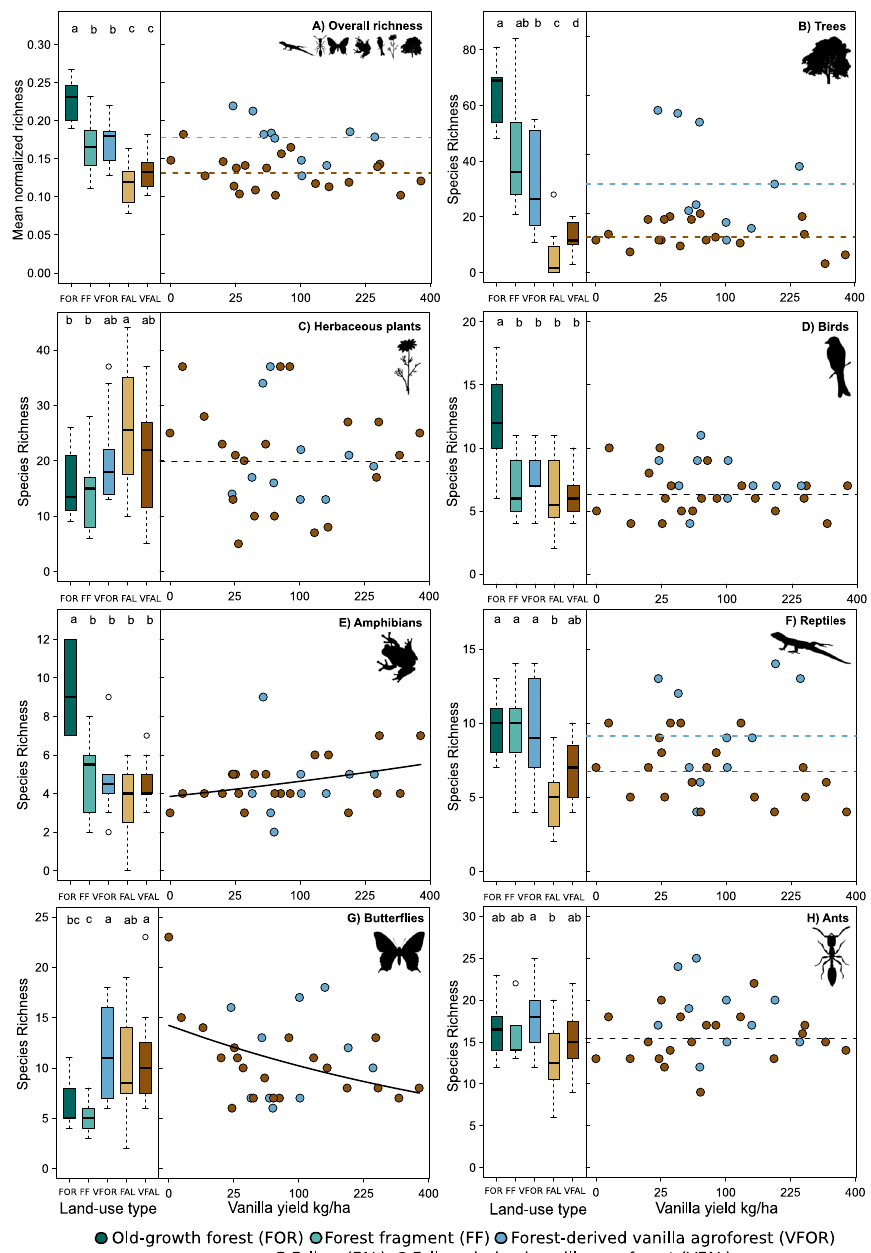
Fig. 1 Overall species richness (mean normalized richness across all taxa) and individual species richness of seven taxonomic groups across land-use types and with increasing vanilla yield. Shown are boxplots of plot-level mean normalized richness across taxa ( A ) and species richness of seven taxa individually ( B – H ) in old-growth forest (FOR = dark green), forest fragment (FF = light green), forest-derived vanilla agroforest (VFOR = blue), fallow (FAL = yellow) and fallow-derived vanilla agroforest (VFAL = brown). n = 10 for each FOR, FF and VFOR & n = 20 for each FAL and VFAL. The line inside the boxplot represents the median of each land-use type. The lower and upper boundaries of the boxplot show the 25th – 75th percentiles of the observational data, respectively, and the whiskers show the 1.5 interquartile range. Outliers are shown as dots. Letters indicate signi fi cant differences between land-use types based on pairwise Tukey ’ s honest or Wilcoxon signi fi cance tests (Statistical test results in Supplementary Tables 4 – 6). Scatterplots (VFOR = blue and VFAL = brown) show the relationship between plot-level mean normalized richness ( A ) and plot-level species richness of the seven taxa ( B – H ) with vanilla yield. Lines indicate model predictions (Statistical test results in Supplementary Tables 1 and 2). Horizontal dashed lines are intercept-only linear models (lines are based on the mean of the distribution). Solid lines indicate statistically signi fi cant relationships ( p < 0.05). Two colored lines (VFOR = blue and VFAL = brown) are shown as dashed lines if land-use history was signi fi cant as an additive term but there was no signi fi cant relationship between species richness with vanilla yield. Solid colored lines indicate that the effect of vanilla yield was moderated by land-use history. Sample size: n = 70 plots for herbaceous plants, birds, amphibians, reptiles, butter fl ies, and ants; n = 68 plots for trees; n = 30 plots for vanilla yield. Note the sqrt-scale for vanilla yield/kg. Icons from phylopic.org (see Supplementary Table 19 for attributions).